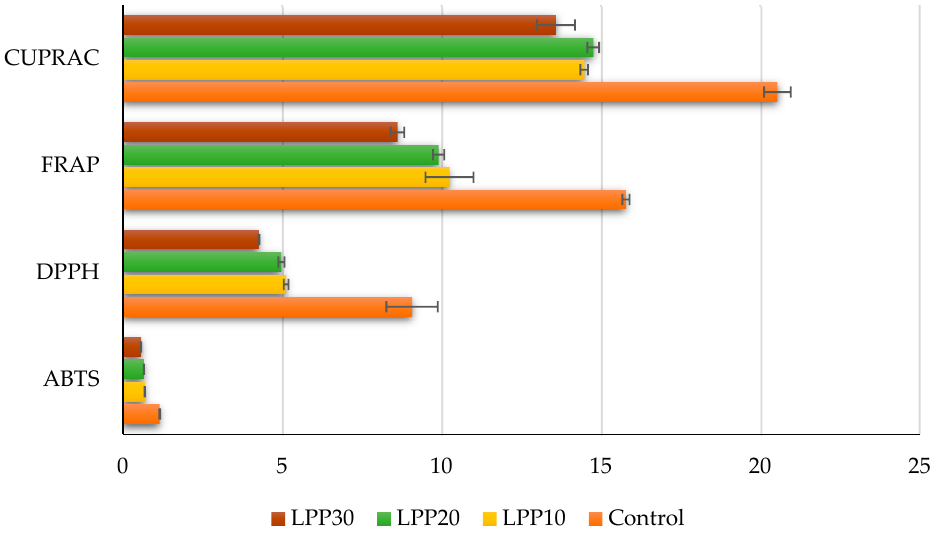
Figure 3. Antioxidant properties of bonbon formulations: ABTS—mMTE/g dw; DPPH, FRAP, CUPRAC— µ MTE/g dw.